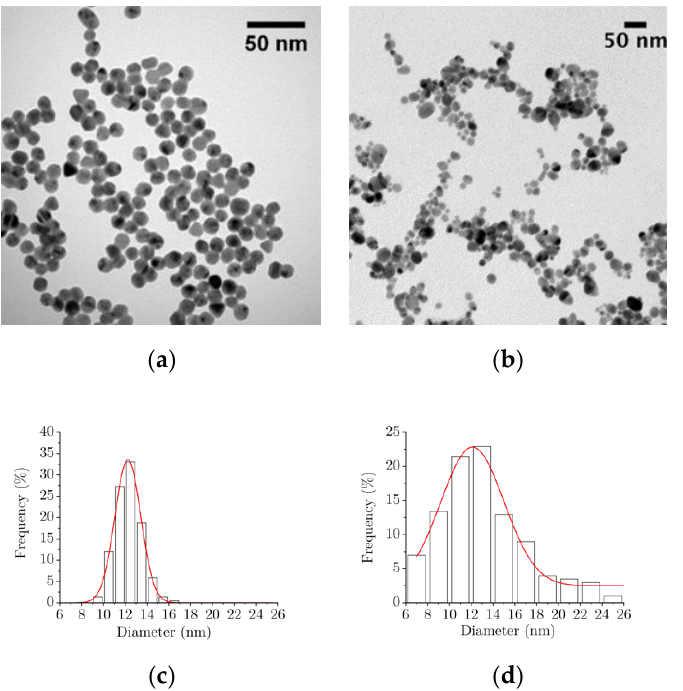
Figure 1. TEM micrographs and size distributions of ( a , c ) gold nanoparticles (AuNPs) and ( b , d ) silver nanoparticles (AgNPs).